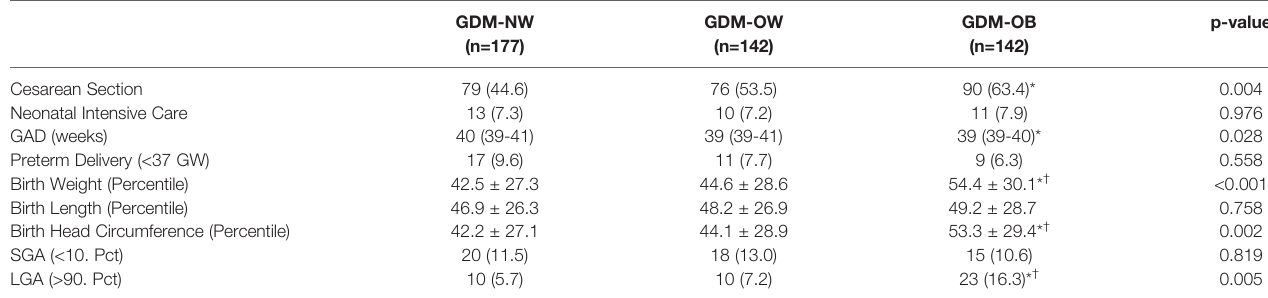
Data are mean ± SD or median (IQR) and count (%) forpatients with GDM andnormal weight (GDM-NW) vs. overweight (GDM-OW)and obese patients (GDM-OB). GAD, gestational age at delivery; SGA, small for gestational age offspring; LGA, large for gestational age offspring.